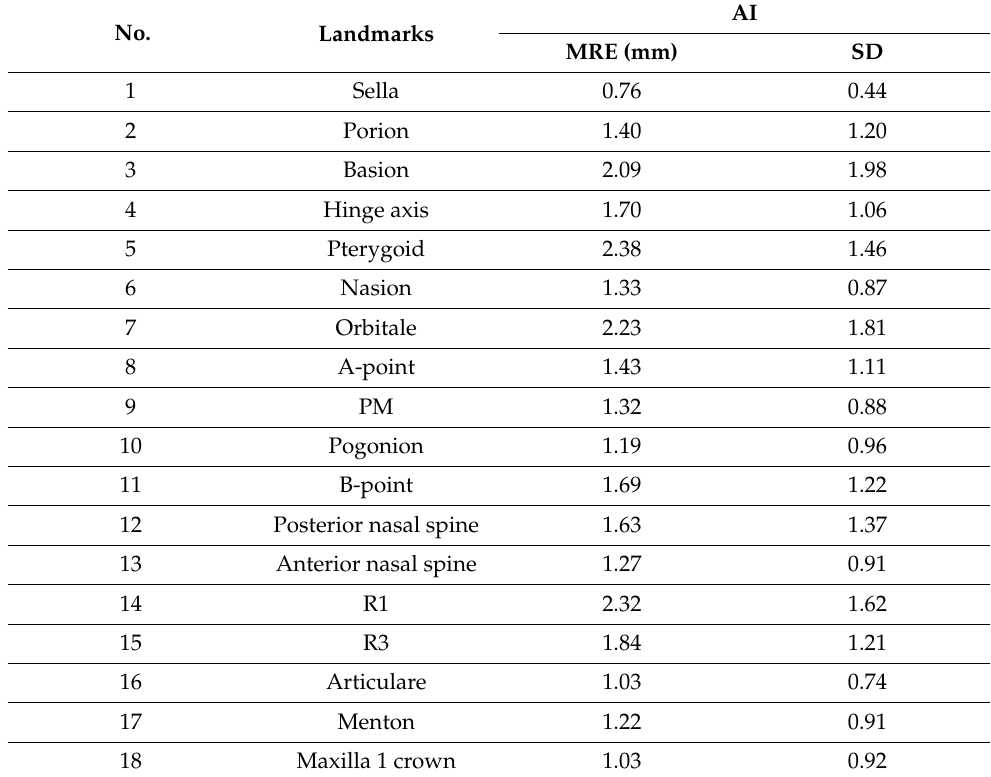
Table 2. Results of landmark detection in terms of mean radial error.